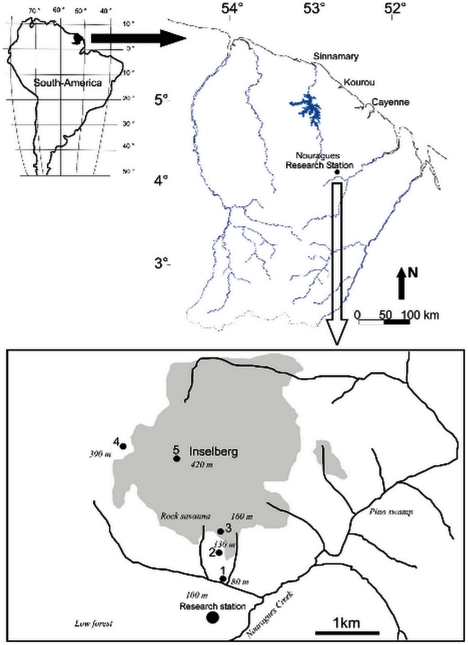
Map of the study area and location of the four sampling stations (1–4).The grey area delineates the inselberg site (maximum elevation = 430 m asl).